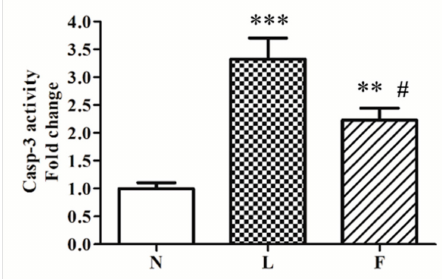
Figure 6. Caspase 3 activity. The analyses of caspase 3 (casp-3) activity was measured by colorimetric assay. Data were graphically represented as mean ± standard error on the mean (SEM) of eight di ff erent animals for each group. Significant di ff erences are shown: ** p < 0.01 vs. N; *** p < 0.001 vs. N; # p < 0.05 vs.